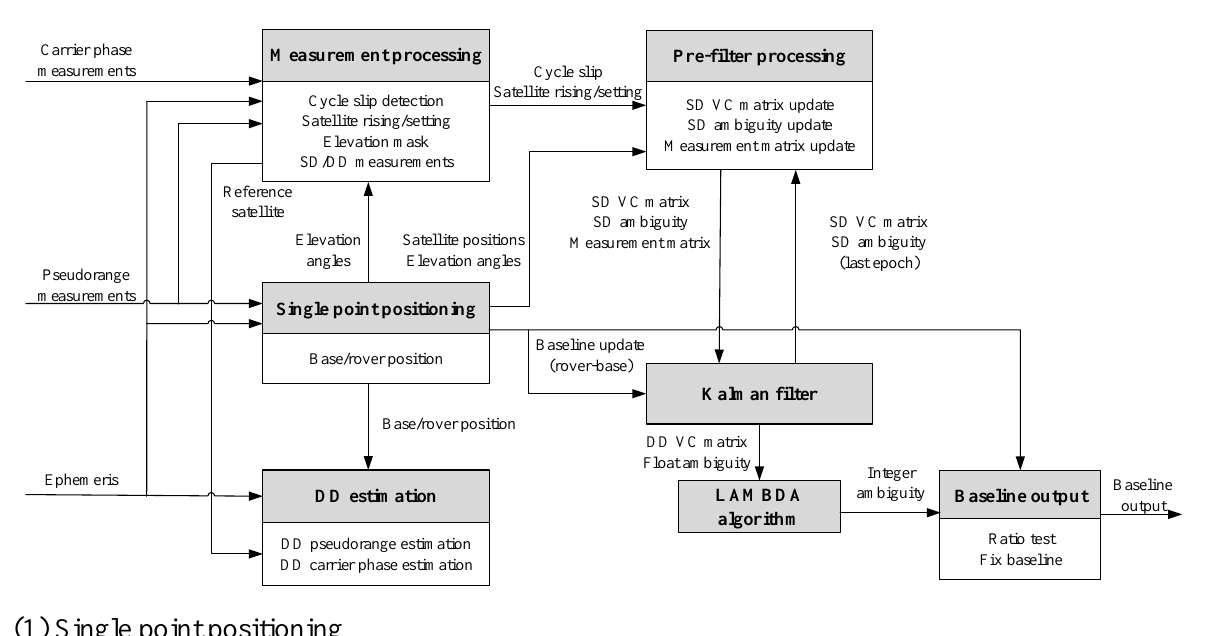
Figure 1. Flowchart of GPS/BDS combined